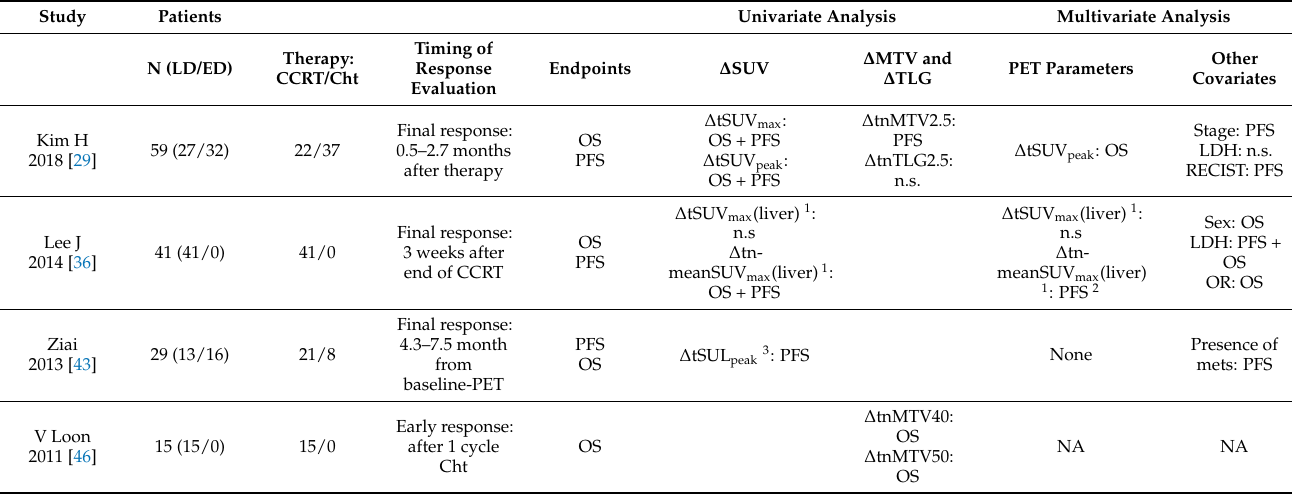
Table 4. Prognostic value of PET parameter change, early and final response evaluation. All PET parameters were compared with the baseline PET